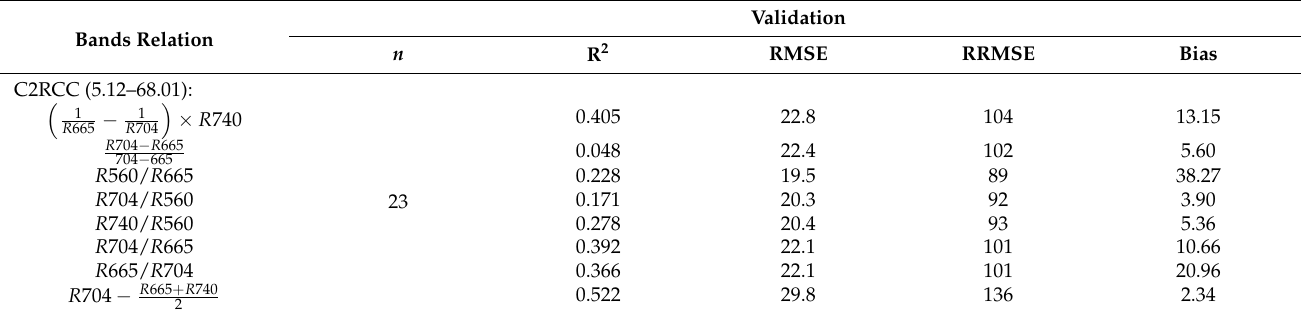
Table A6. Chl_a below 5 mg/m 3 validation results for in situ spectrometry waters quality algorithms and AC